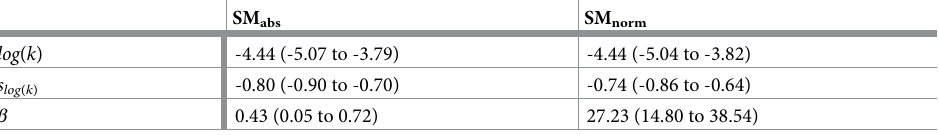
Table 1. Group-level mean estimates and 95% HDIs of log ( k ), s log(k) and β using the softmax choice